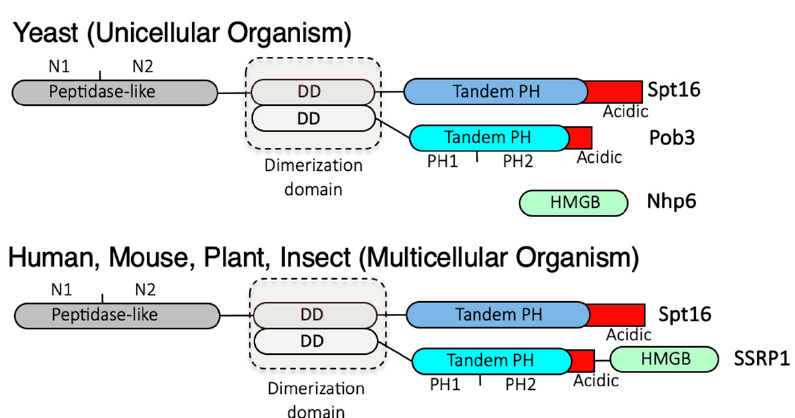
Figure 1. Schematic structures of FACT complex in yeast and higher eukaryotes. N1: subdomain of peptidase-like domain 1, N2: subdomain of peptidase-like domain 2, DD: dimerization domain, Tandem PH: tandem pleckstrin homology domain, PH1: pleckstrin homology domain 1, PH2: pleckstrin homology domain 2, Acidic: acidic amino acid cluster, HMGB: high-mobility group box.